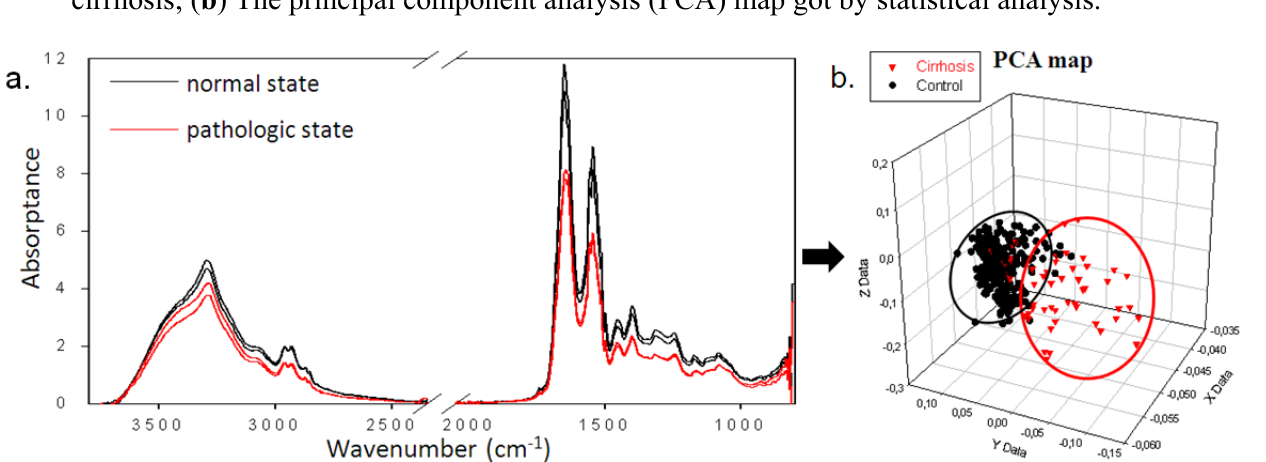
Figure 3. ( a ) Traditional optical absorptance spectrum of human serum with and without cirrhosis; ( b ) The principal component analysis (PCA) map got by statistical